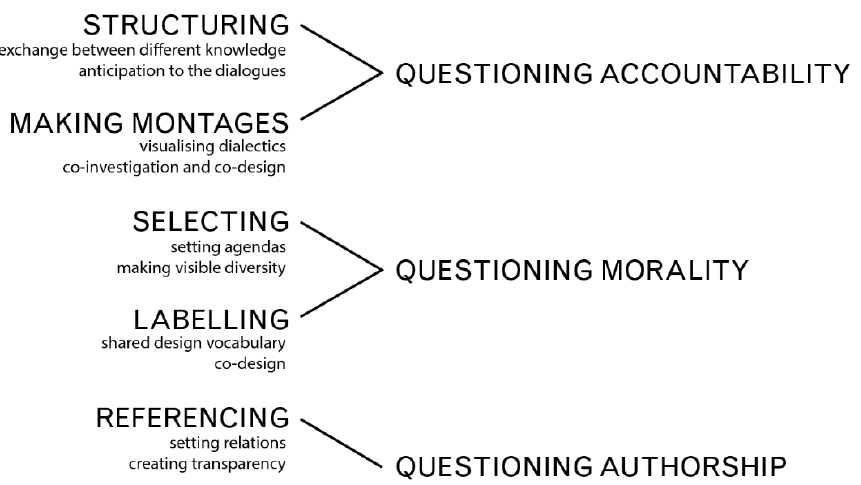
Figure 7. Overview of the interplay between atlas techniques and ethical questions. Source: Barbara Roosen. Our fifth technique, referencing (Section 3.5),